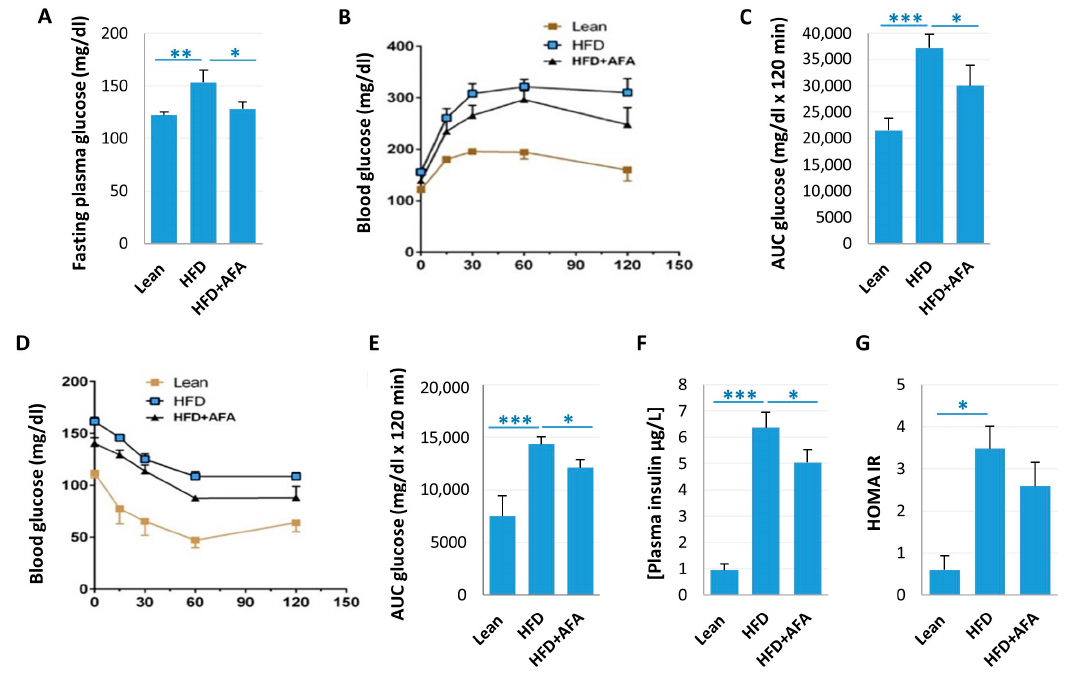
Figure 2. AFA assumption improves glucose dysmetabolism in HFD mice. Fasting glycaemia ( A ), glucose tolerance test (GTT) ( B ), area under the curve (AUC) for GTT ( C ), insulin tolerance test (ITT) ( D ), area under the curve for ITT ( E ), plasma insulin levels ( F ) and HOMA index ( G ). Results are shown as means ± SEM of 8 animals/group. * p < 0.05, ** p < 0.01, *** p < 0.001 vs. STD mice and vs. HFD-fed